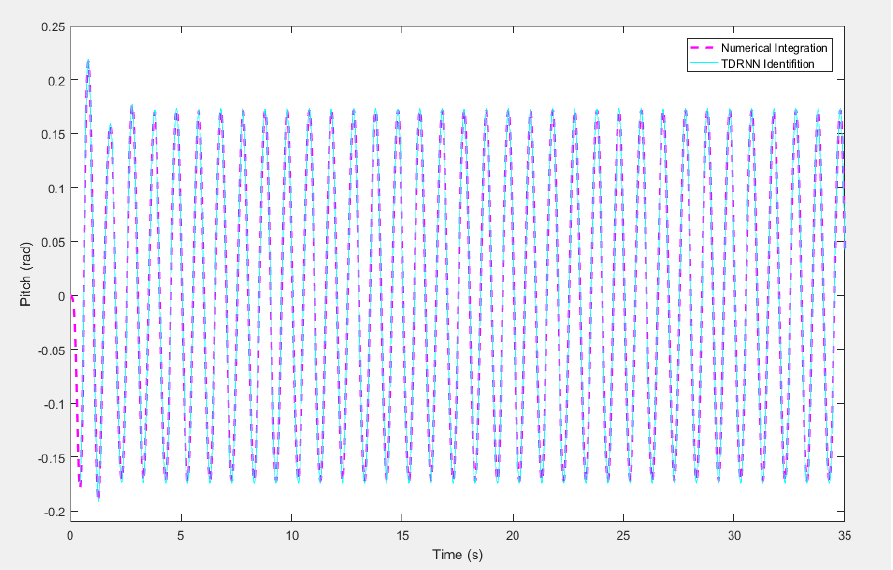
Figure 9. Response of sine input signal.